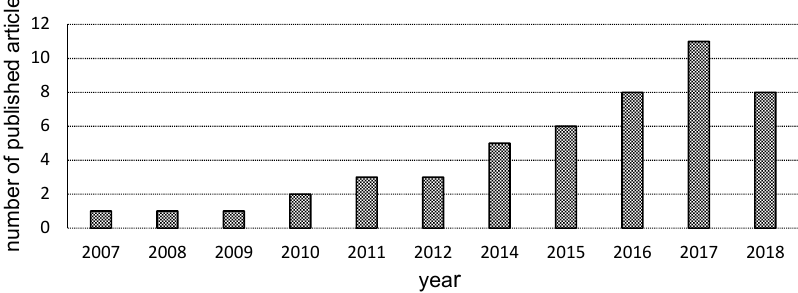
Figure 3. Distribution of the number of published papers based on publication year.